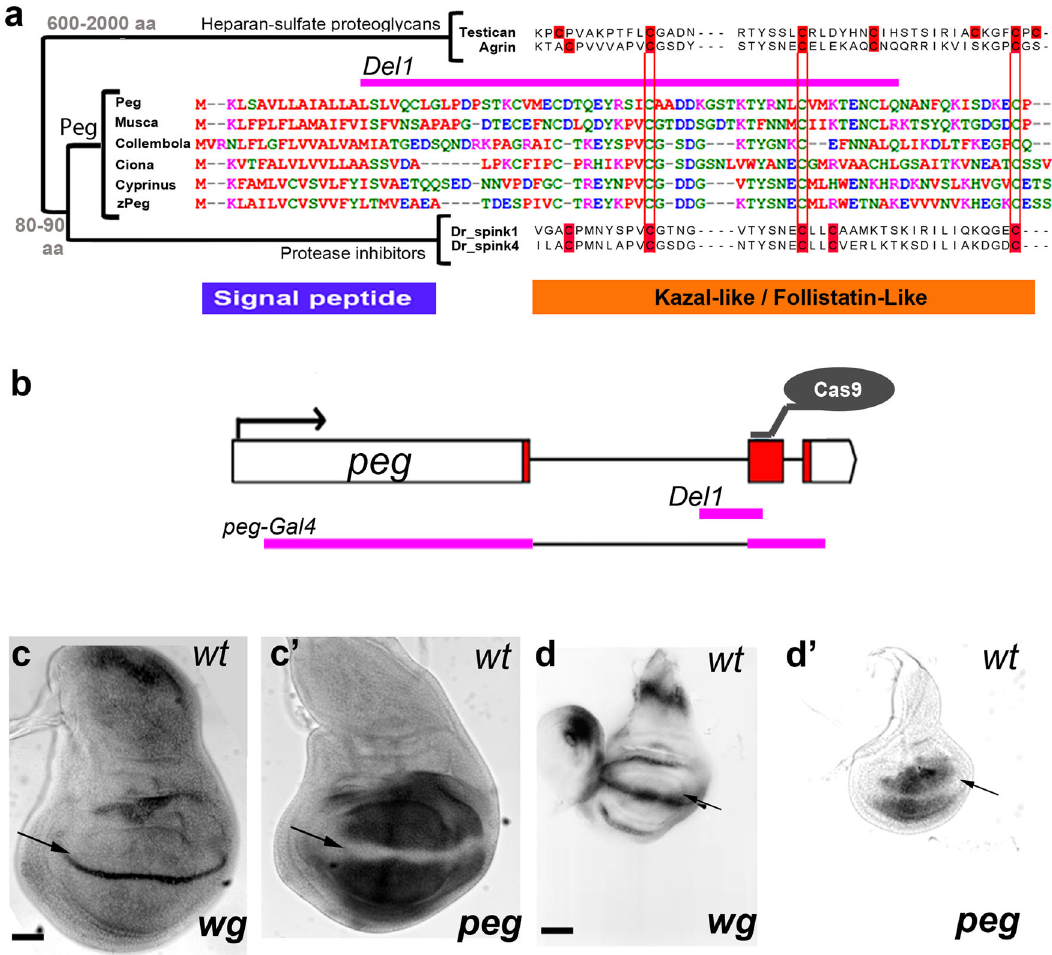
Fig. 1 peg a conserved smORF is expressed in wing imaginal discs in a pattern complementary to wg . a Phylogenetic tree and alignments of different proteins with FS-like domains, including Peg, the large secreted proteoglycans Agrin and Testican, and the family of small secreted Serine Protease Inhibitors of the Kazal type (Spinks). Danio rerio (Dr_) spinks are presented here. Size range in aa is indicated for each group of genes. Note the similarity between Peg and putative homologues in another dipteran ( Musca ), a primitive arthropod ( Collembola ), a basal chordate ( Ciona , a tunicate), and the fi shes Cyprinus (Carp) and Danio rerio (zebra fi sh, zPeg). The pattern of conserved cysteines (red) in each family of peptides is indicated in red. The signal peptide and FS-like domains are indicated in blue and orange, respectively. This protein structure with a signal peptide followed by a single protein domain is similar to other secreted or membrane-associated small ORF peptides, such as antimicrobial peptides 40 , organelle components 39,41 , and cell signals 11,42 . The peg Del1 allele (pink) removes a large portion of aa from the Peg sequence, including most of the Kazal domain and part of the signal peptide sequence. b peg genomic locus indicating the site targeted for CRISPR/Cas9 mutagenesis, within the peg ORF (red), and the genomic sequences deleted in the different alleles used in this study (pink). c , d In-situ hybridization for wg and peg in late (c, c´) and mid (d, d´) third instar wing imaginal discs. peg is expressed in a pattern complementary to wg (arrows, see also Butler et al. 43 ). Scale bars: c , d : 50 µ